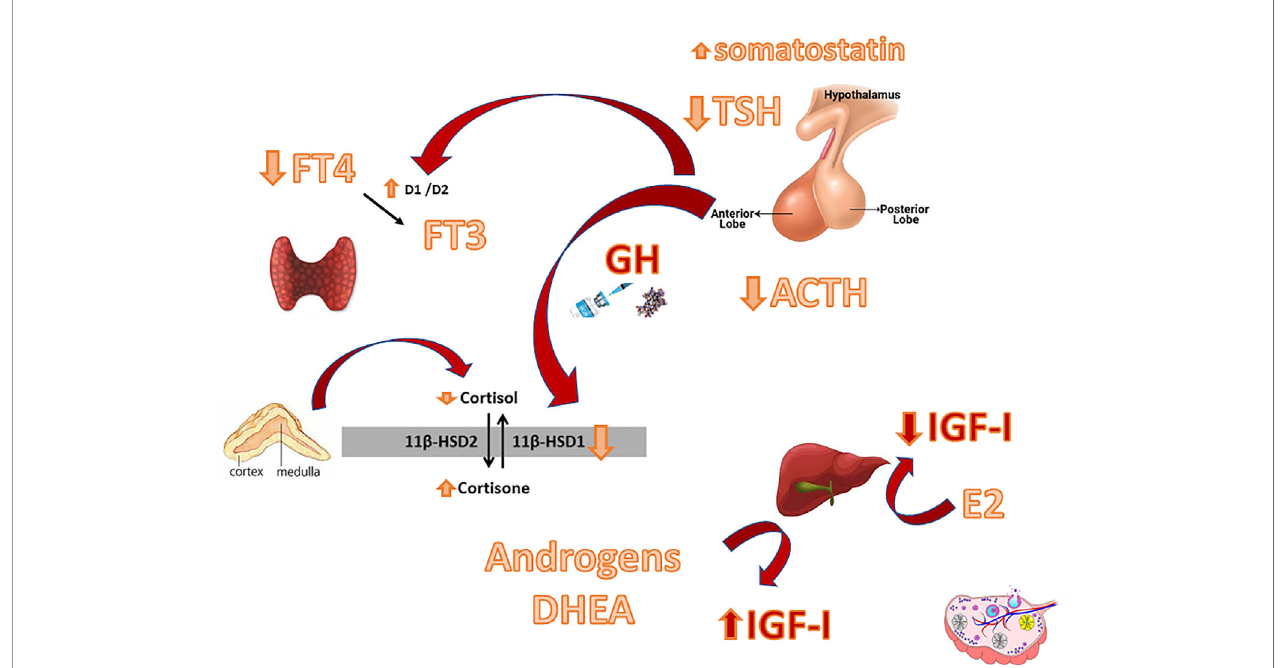
FIGURE 1 | Main interactions between the GH-IGF-I system and other hypothalamic-pituitary axes. D1/D2: Deiodinase type 1/ Deiodinase type 2. 11ßHSD: 11ß- hydroxysteroid